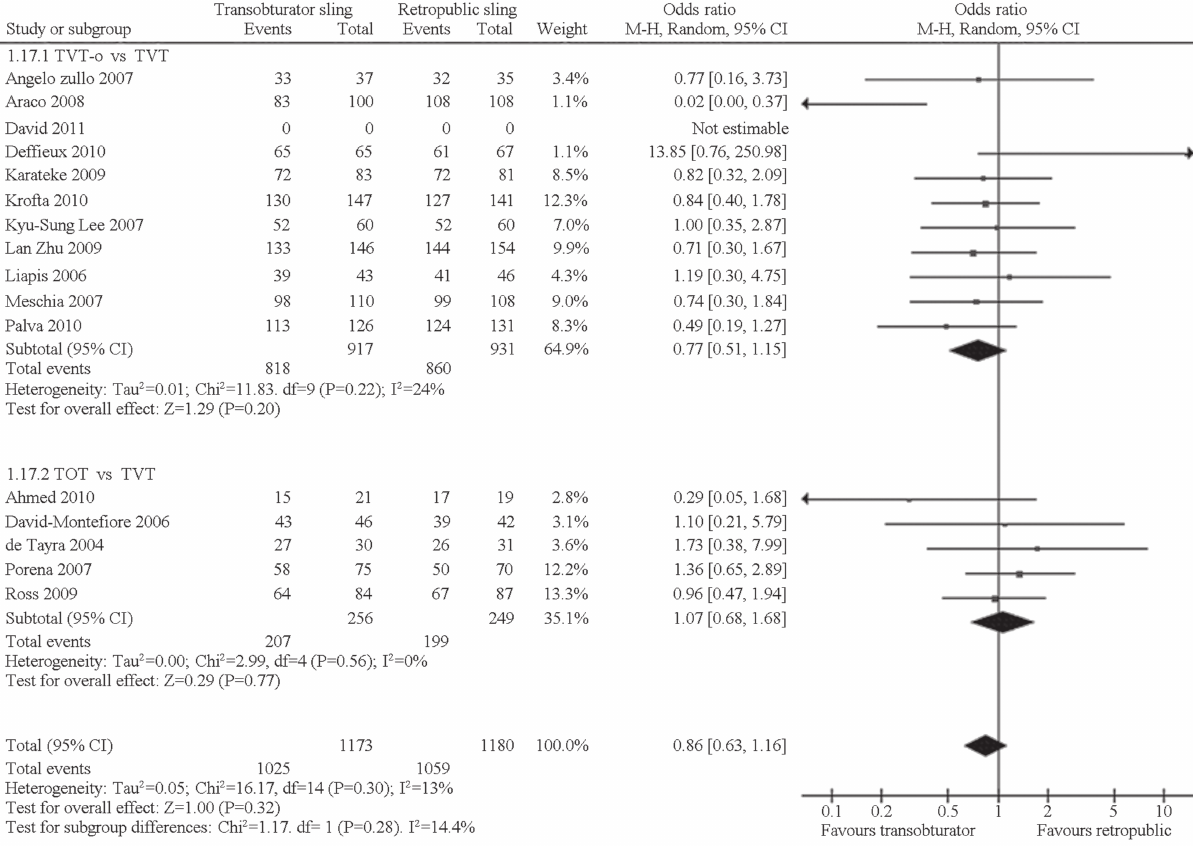
Figure 2 - Meta-analysis of the objective cure of the two approaches (TVT-O and TOT) in comparison with